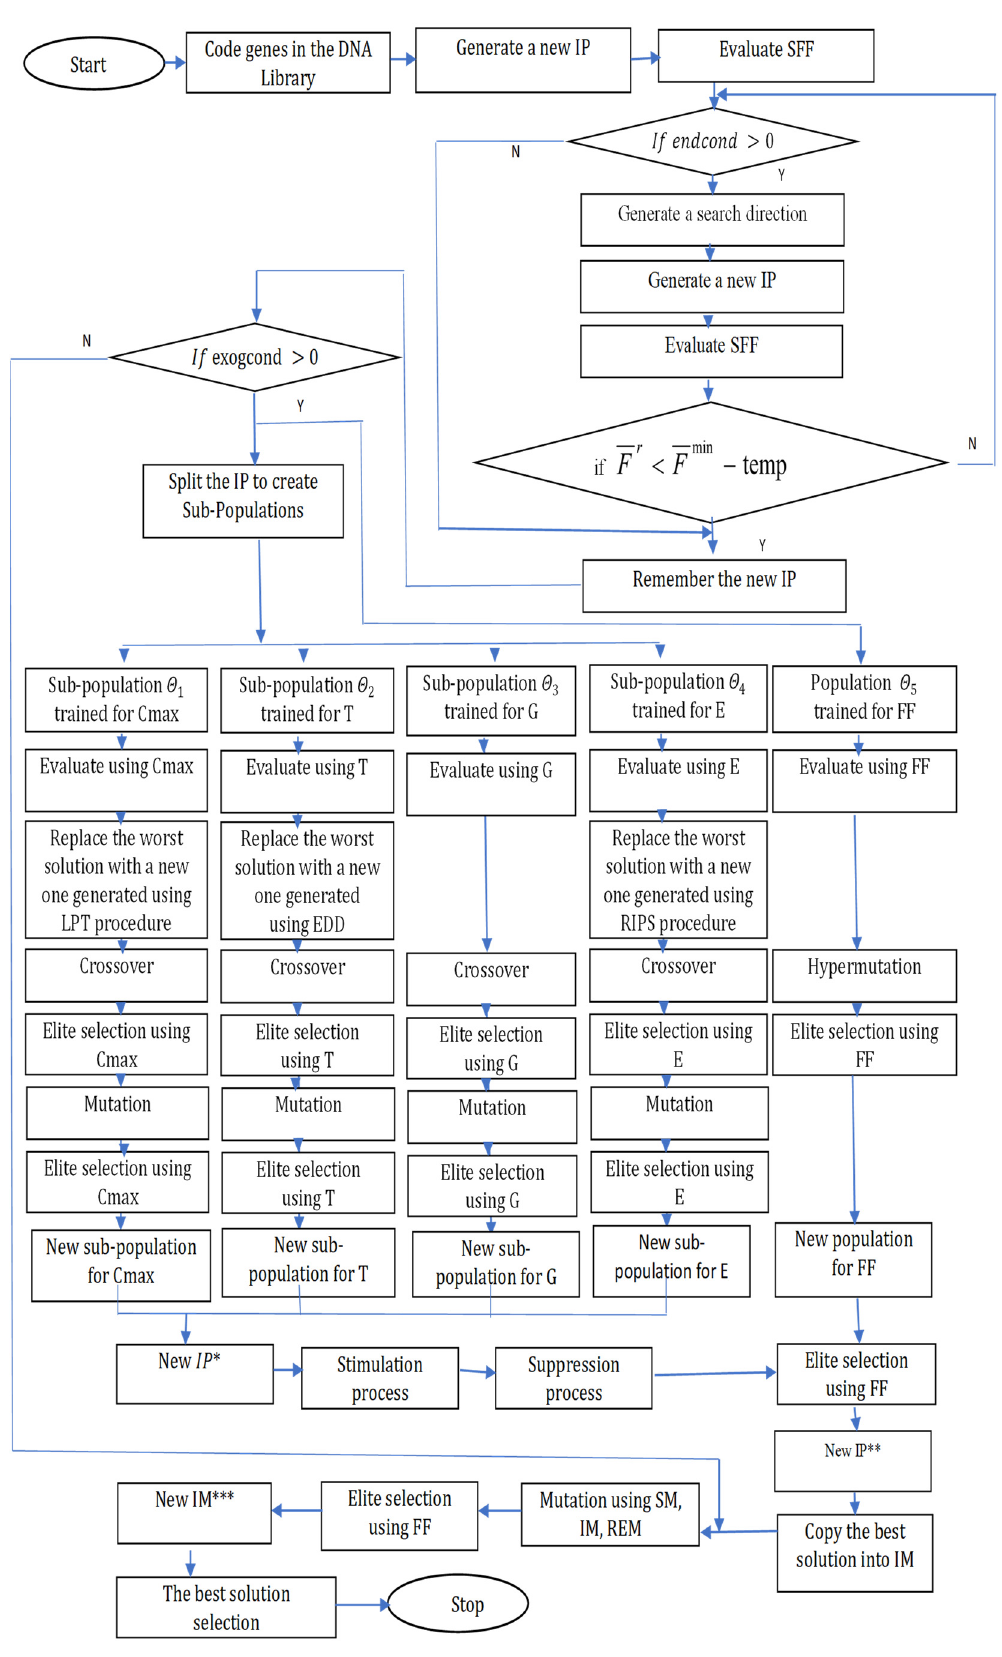
Figure 15. Block diagram of the Multi Objective Immune Algorithm.